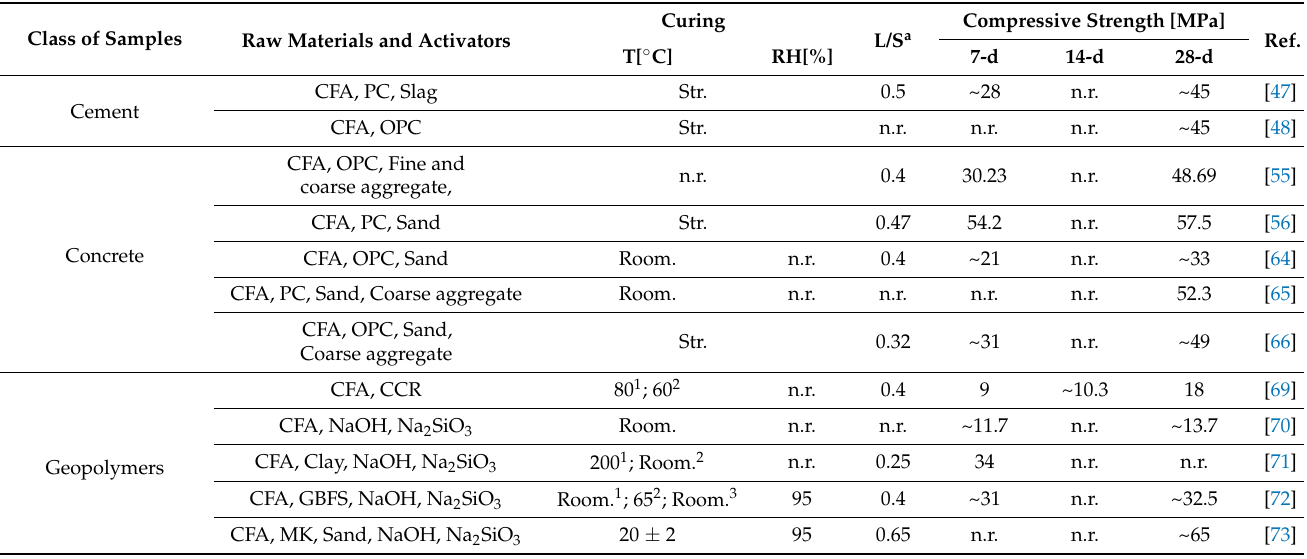
Table 3. CFA-based materials studies reported in the literature: raw materials; activators; L/S, curing conditions and sample